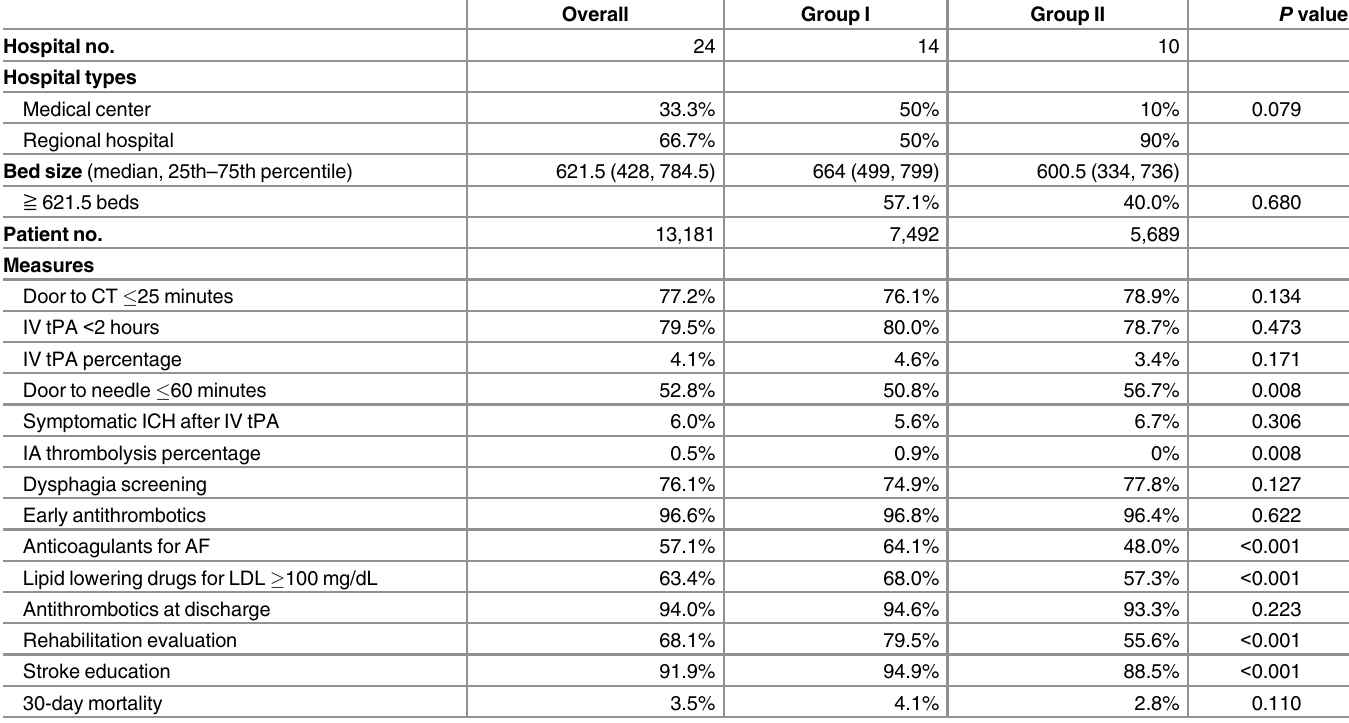
Table 1. Quality Measures of 24 Hospitals Participating in BTS-Stroke Activity in 2010 –